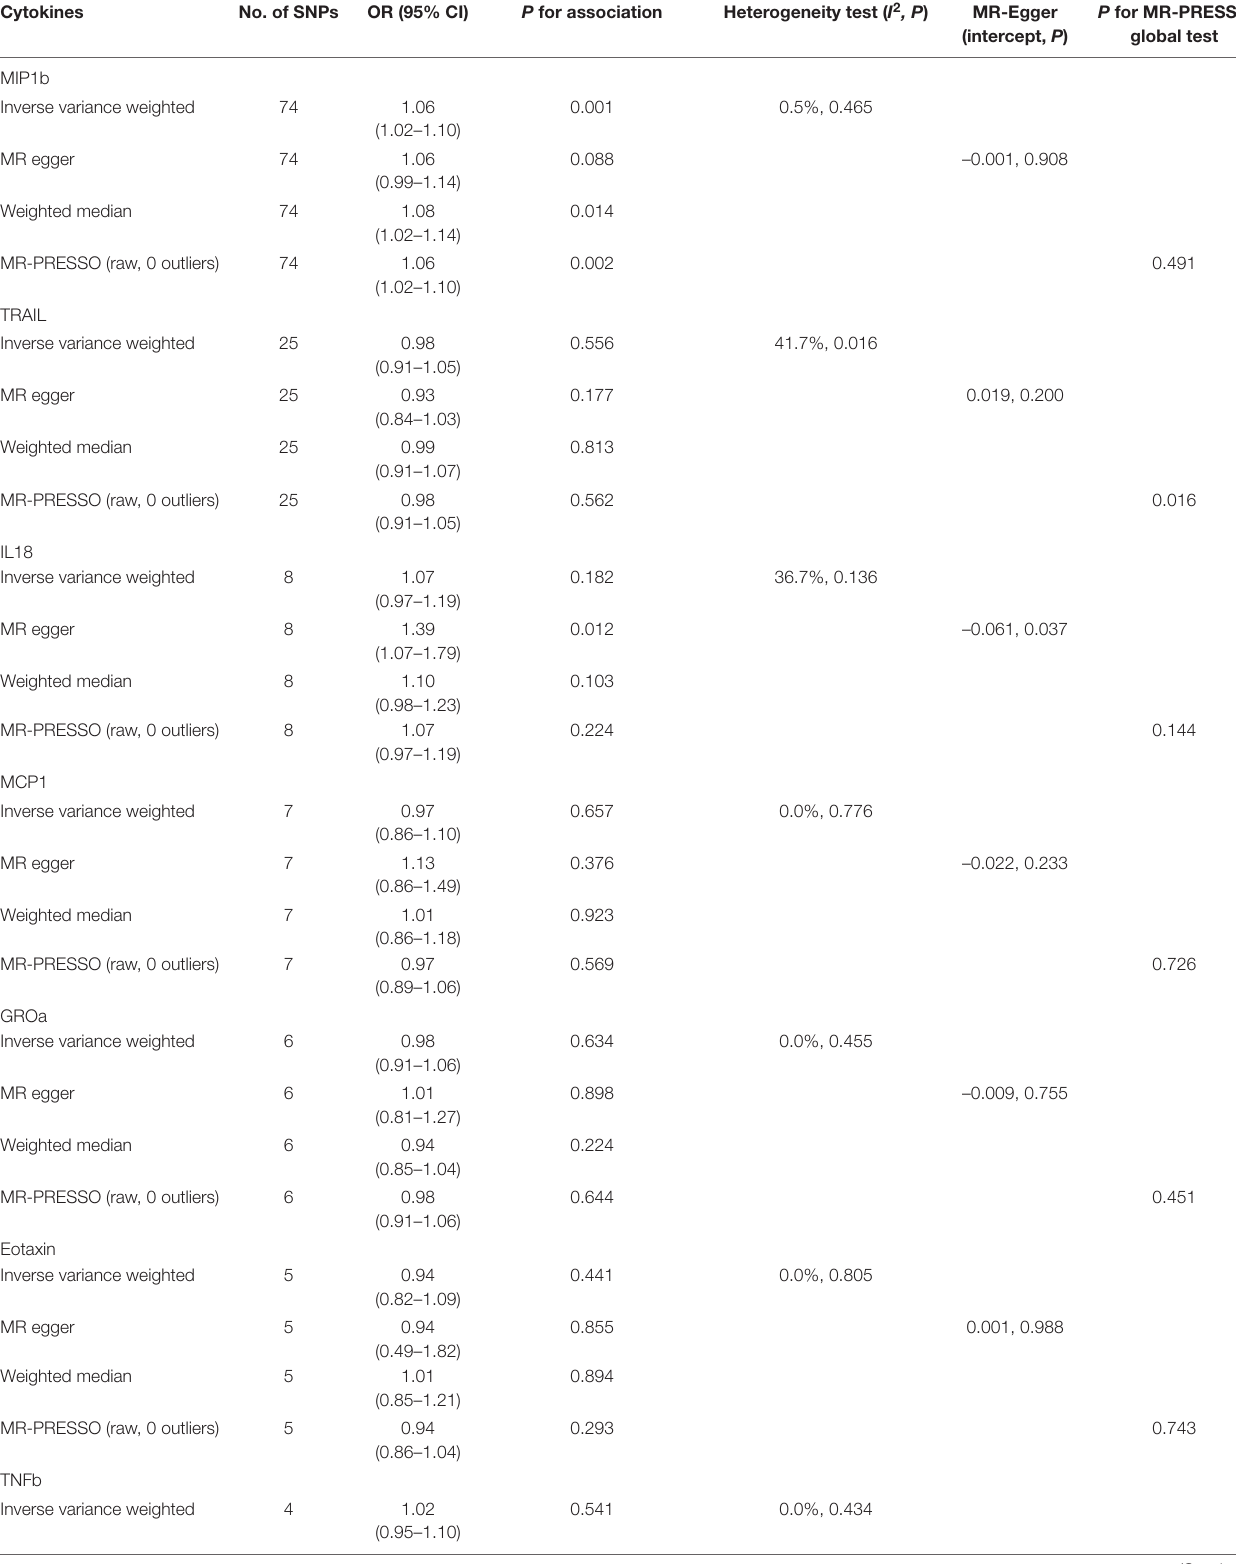
TABLE 1 | MR analyses of genetically predicted levels of circulating inflammatory cytokines and risk of Parkinson’s disease. Cytokines No. of SNPs OR (95%